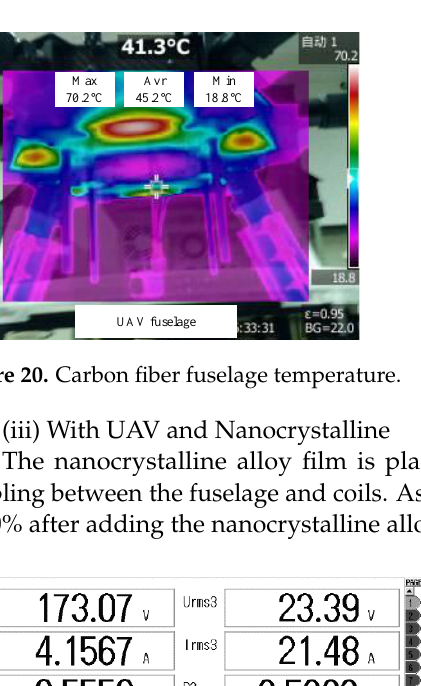
Figure 19. Output characteristics with UAV.